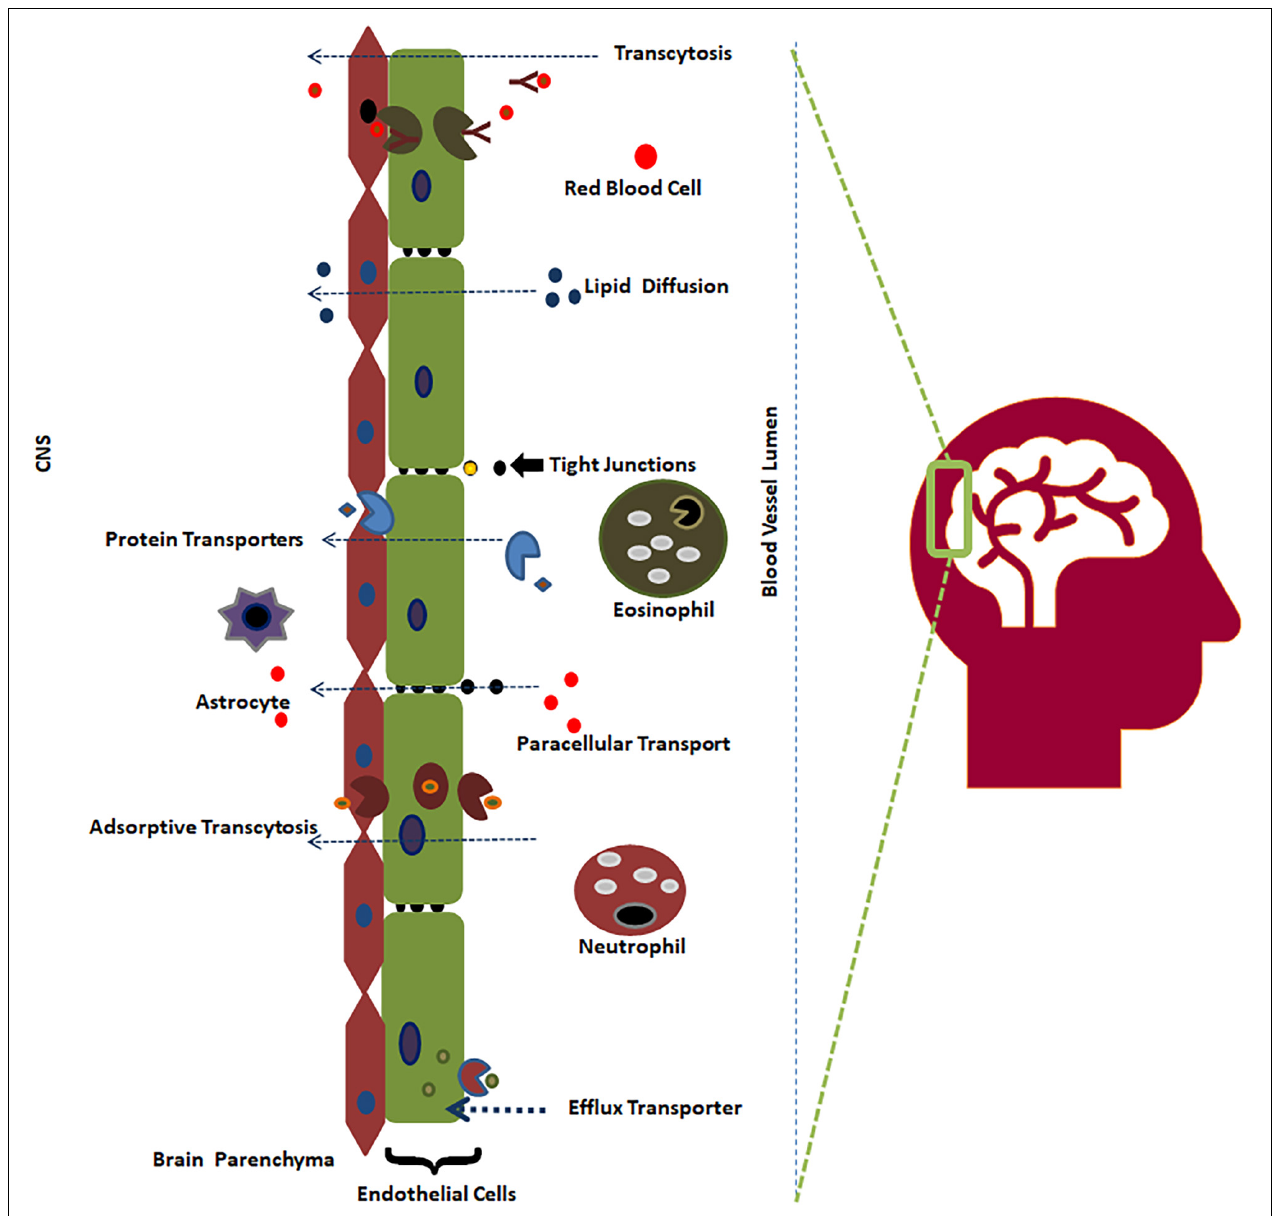
FIGURE 1 | The BBB and its permeability mechanism (Saxena et al.,